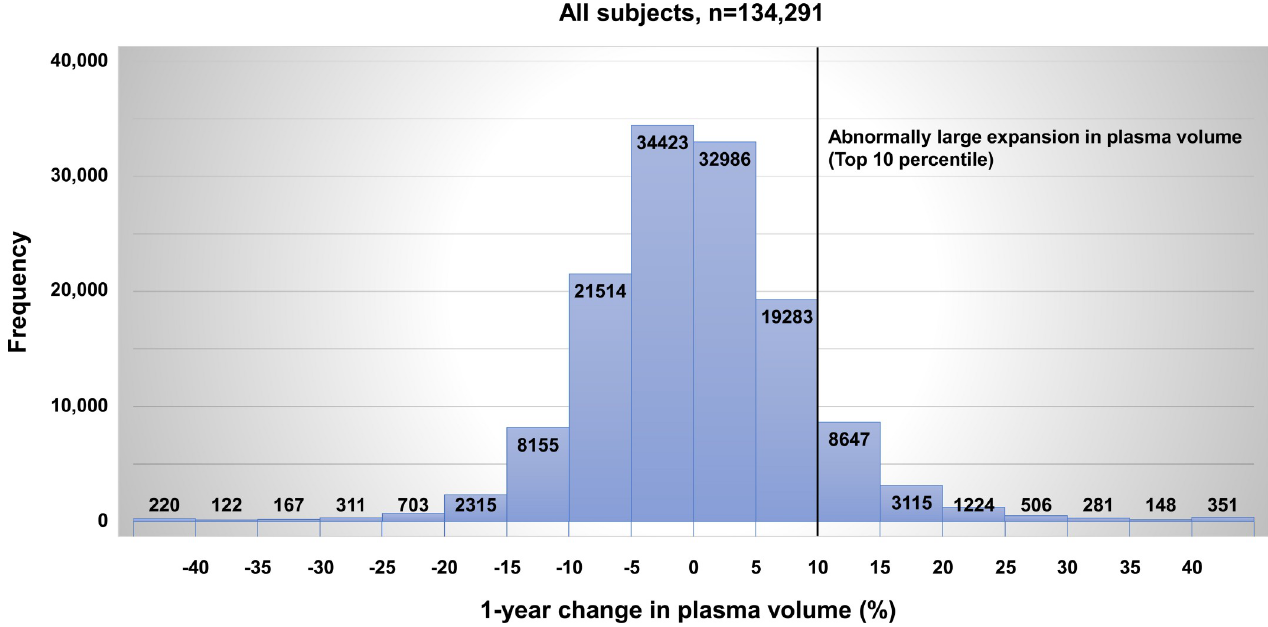
Fig 2. Association between frequency and 1-year change in plasma